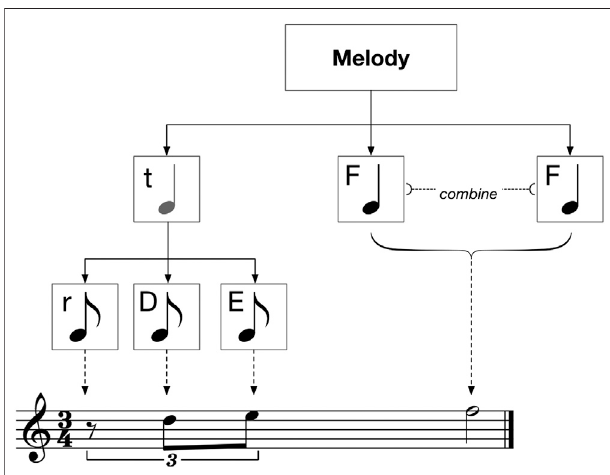
FIGURE 3 | A melody tree containing a triplet and a combine